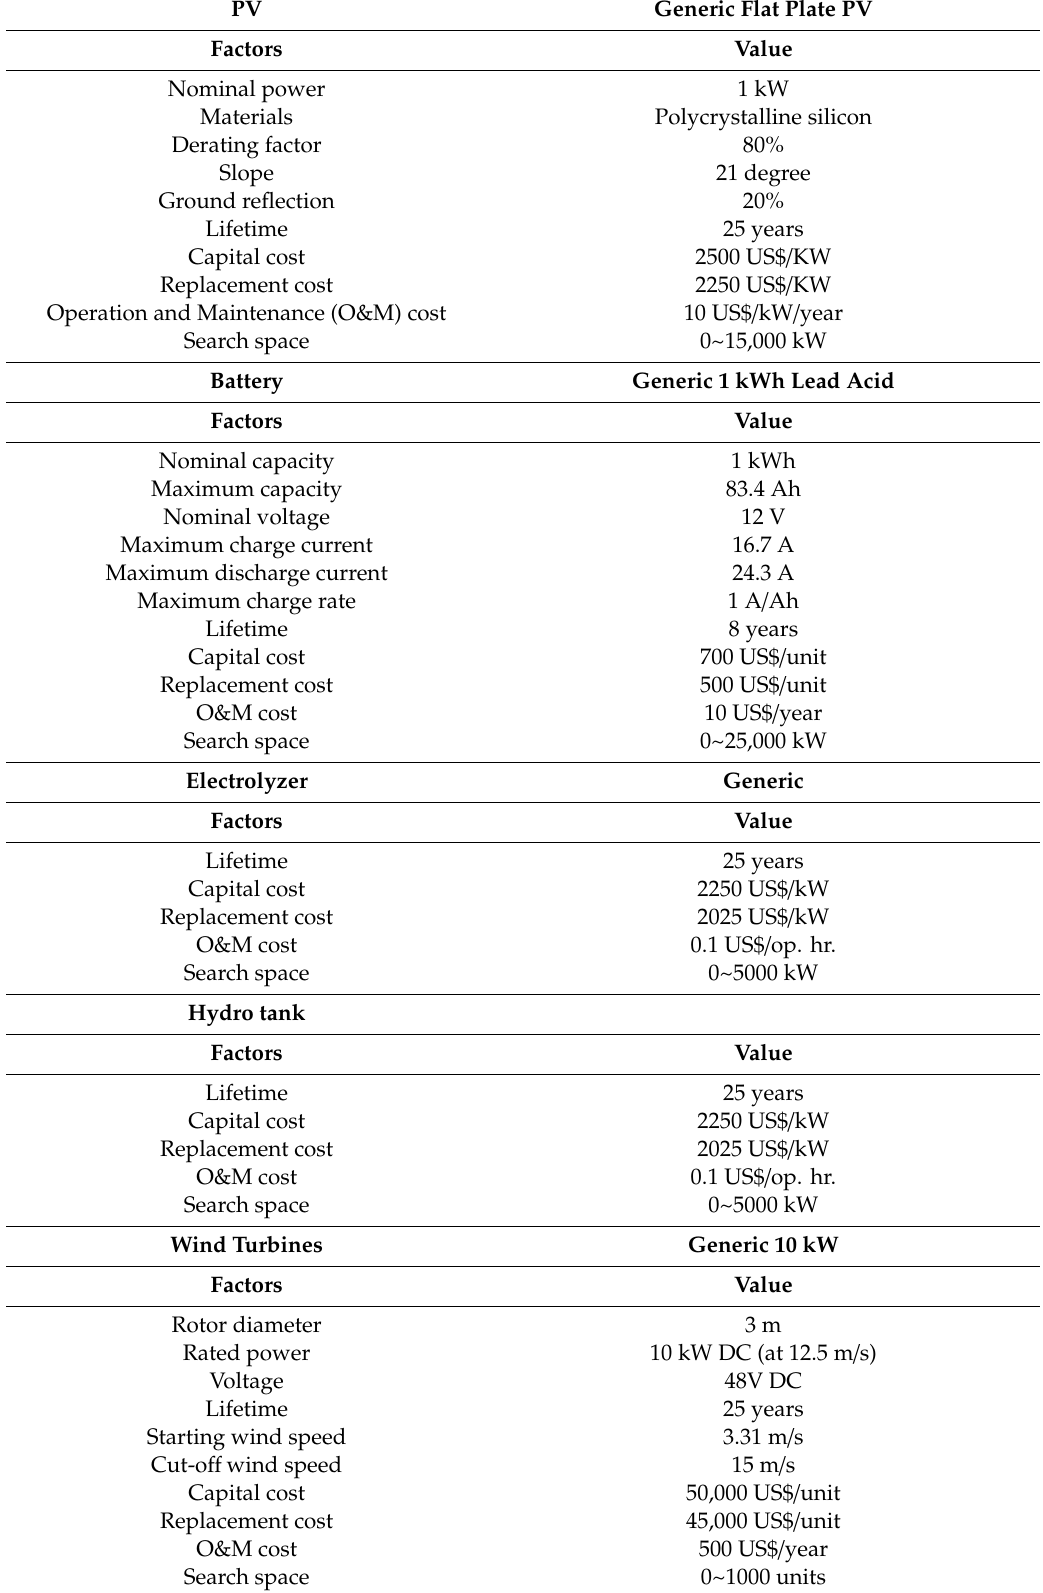
Table 3. Technical and economic specifications of the system